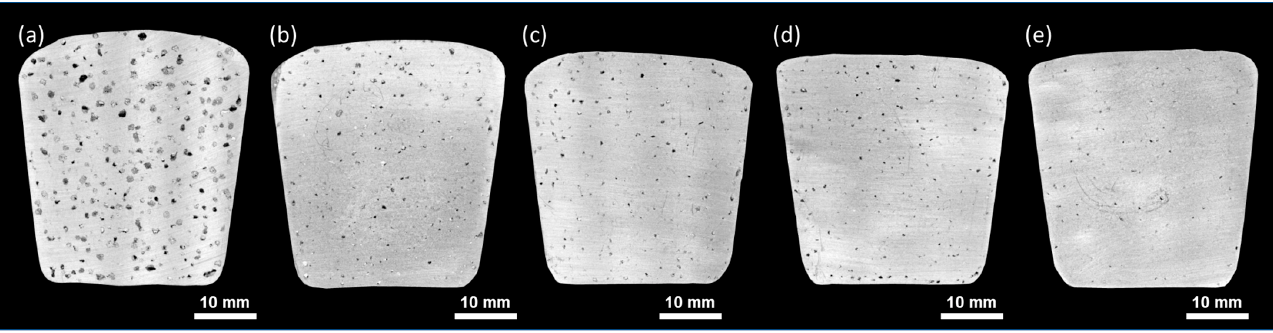
Figure 15. Internal porosity in the RPT samples solidified under partial vacuum during the in-line HSMC degassing process. ( a ) No HSMC; ( b ) 500 rpm; ( c ) 1000 rpm; ( d ) 1500 rpm; ( e ) 2000 rpm. Reprinted with permission from [28]. Copyright 2022 Elsevier.